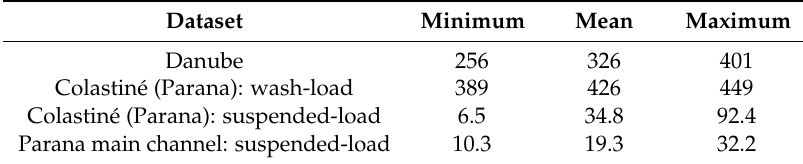
Table 2. Significant values of total concentrations in mg ¨ L ´ 1 from field